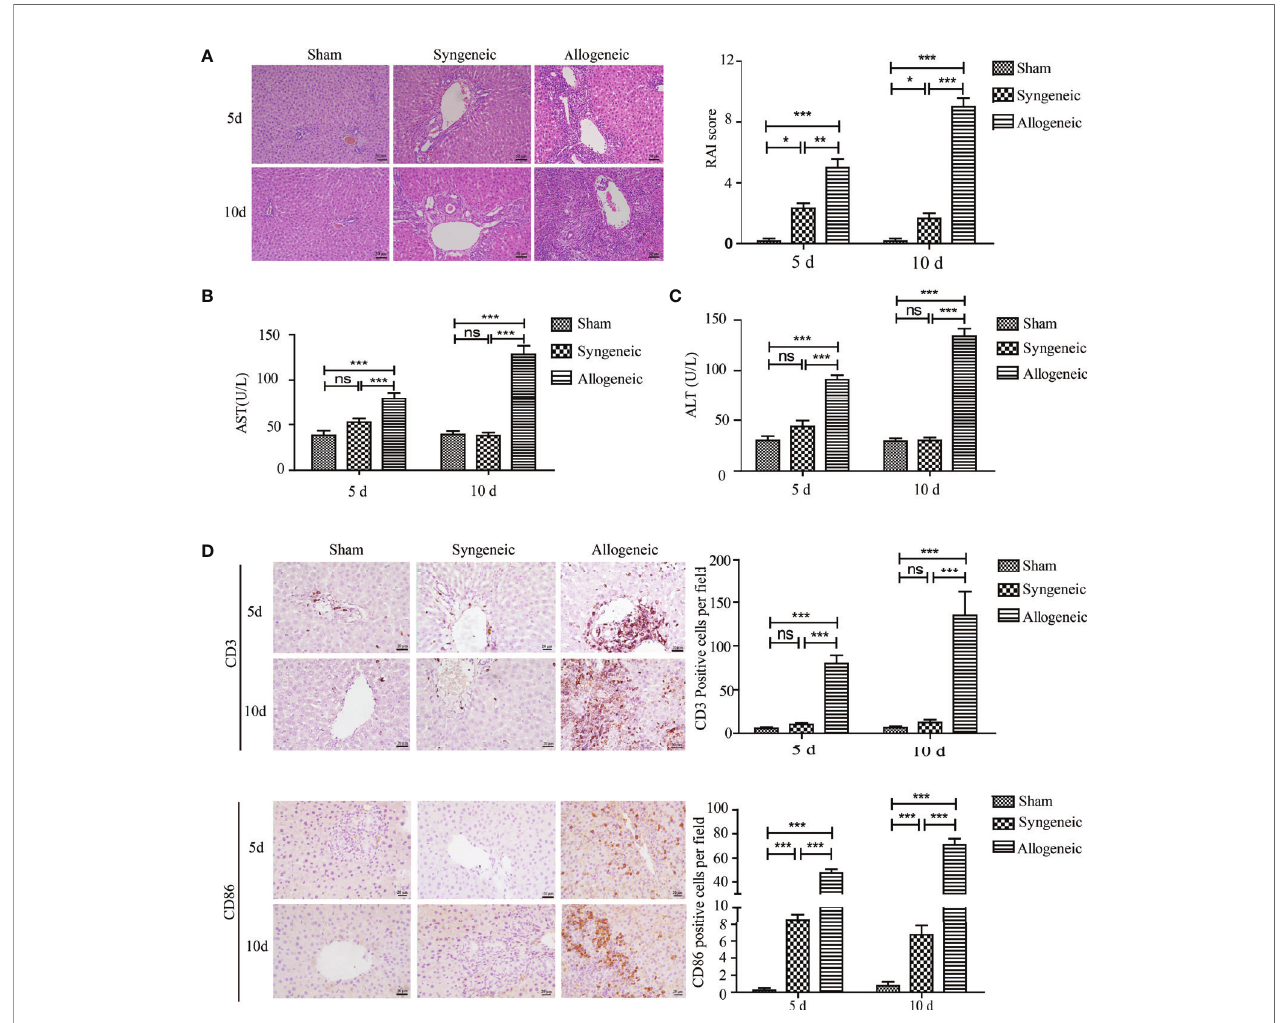
FIGURE 1 | Establishment of a rat liver transplantation model and in fl ammatory cell in fi ltration in liver grafts. Liver grafts retrieved from Lewis rats were orthotopically transplanted into BN rats or Lewis rats (syngeneic and allogeneic groups respectively). The sham group received only the opening and closing of the abdomen. (A) Representative H&E staining of liver grafts (magni fi cation, ×200). The right panel shows the RAI scores of the three groups. Severe parenchymal necrosis and destruction of bile ducts were present in the allogeneic group compared with the allogeneic and sham groups. (B, C) Serum concentrations of AST and ALT in recipient rats. Serum AST and ALT levels in the allogeneic group were highest among the three groups. (D) CD3 + and CD86 + in fl ammatory cells in liver grafts measured by IHC (magni fi cation, ×200). The numbers of CD3 + and CD86 + cells per fi eld in liver grafts were counted with Image pro plus and shown in the right panel. Marked in fi ltration of CD3 + and CD86 + in fl ammatory cells was observed in the allogeneic group, whereas the allogeneic and sham groups had few CD3+ and CD86+ in fl ammatory cells. All experiments were performed three times and data are presented as the mean ± SD. * p < 0.05, ** p < 0.01, ***p < 0.001; ns, not signi fi